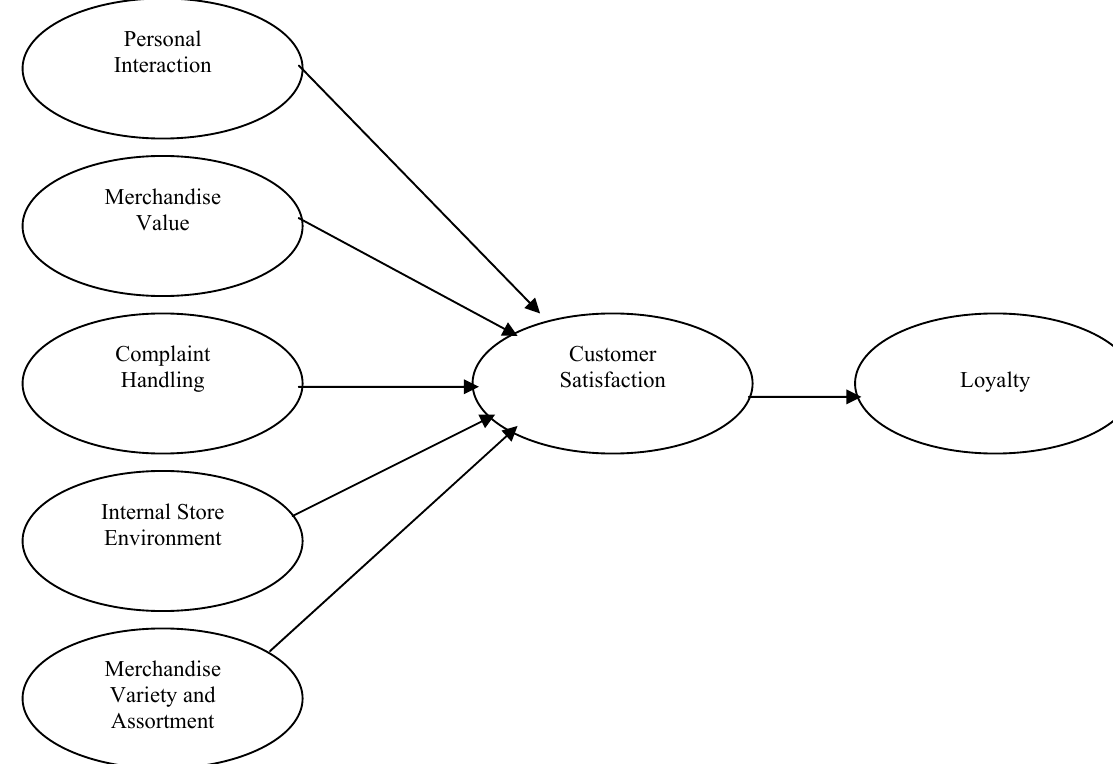
Figure 4: Theoretical model to assess nomological